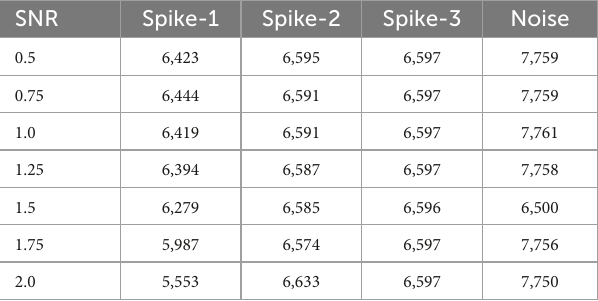
TABLE 1 Number of windows for each class per SNRs in dataset 1.